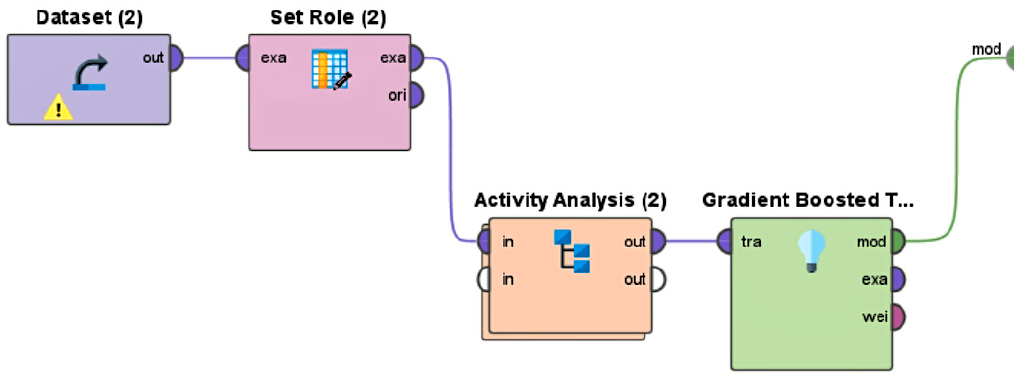
Figure 3. The sub-process of the process shown in Figure 2 that shows the development of the AdaBoost algorithm in this framework that used the Gradient Boosted Trees.